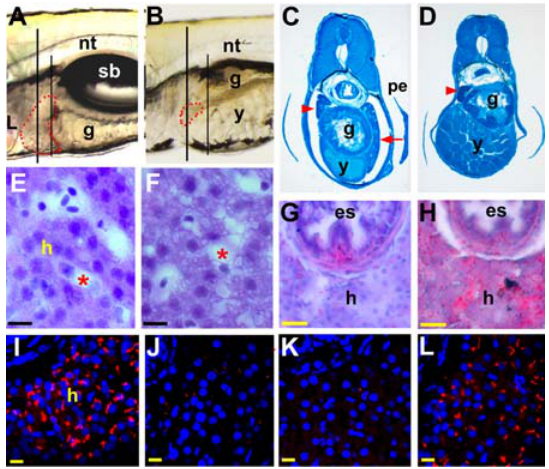
Figure 5. A2ML knock-down phenotypes in the liver. Embryos injected with cont MO ( A, C, E, G, I ), A2ML ATG MO ( B, D, F, H, J ), A2ML UTR MO ( K ), and embryo rescued by co-injection of ATG MO and mRNA ( L ) were analyzed at 5.5 dpf. (C–F) plastic sections, (G–L) cryosections. A–B Lateral live images in the area of the liver (indicated by red dotted line); the short vertical line indicates the plane of section for C and D, the long line for E–L. C–D Methylene blue stain. Red arrowhead points to pancreas, red arrow to liver (in C). E–F Hematoxylin and Eosin (H&E) stained liver section. Asterisks are sinusoids. G–H Lipid staining of liver using Oil-Red O for cont MO (G) and A2ML ATG MO-injected embryos (H). I–L Confocal images for P- glycoprotein IHC; either MO eliminates P-glycoprotein staining (J and K), while mRNA coinjection rescues staining (L). Scale bars represent 10 m m in E–F and 50 m m in G–L. g, gut; h, hepatocytes; L, liver; n, notochord; pe, pectoral fin; y, yolk.